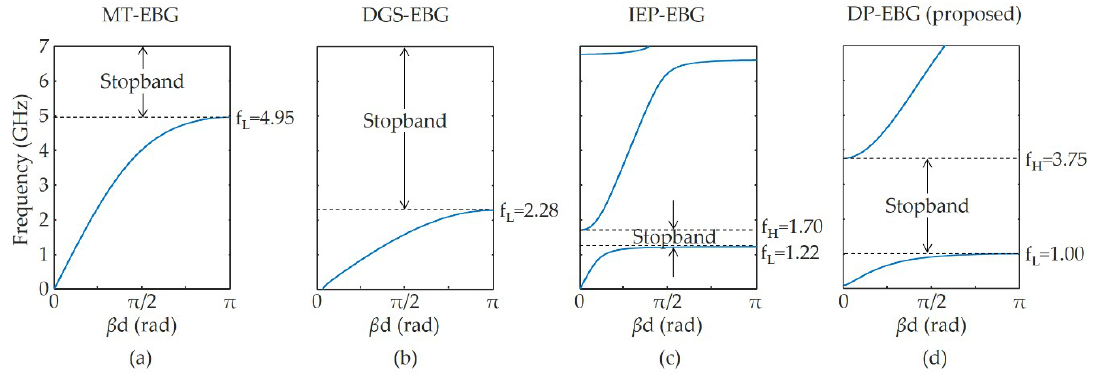
Figure 7. Dispersion diagrams of ( a ) MT–, ( b ) DGS–, ( c ) IEP–, and ( d ) DP–EBG structures.